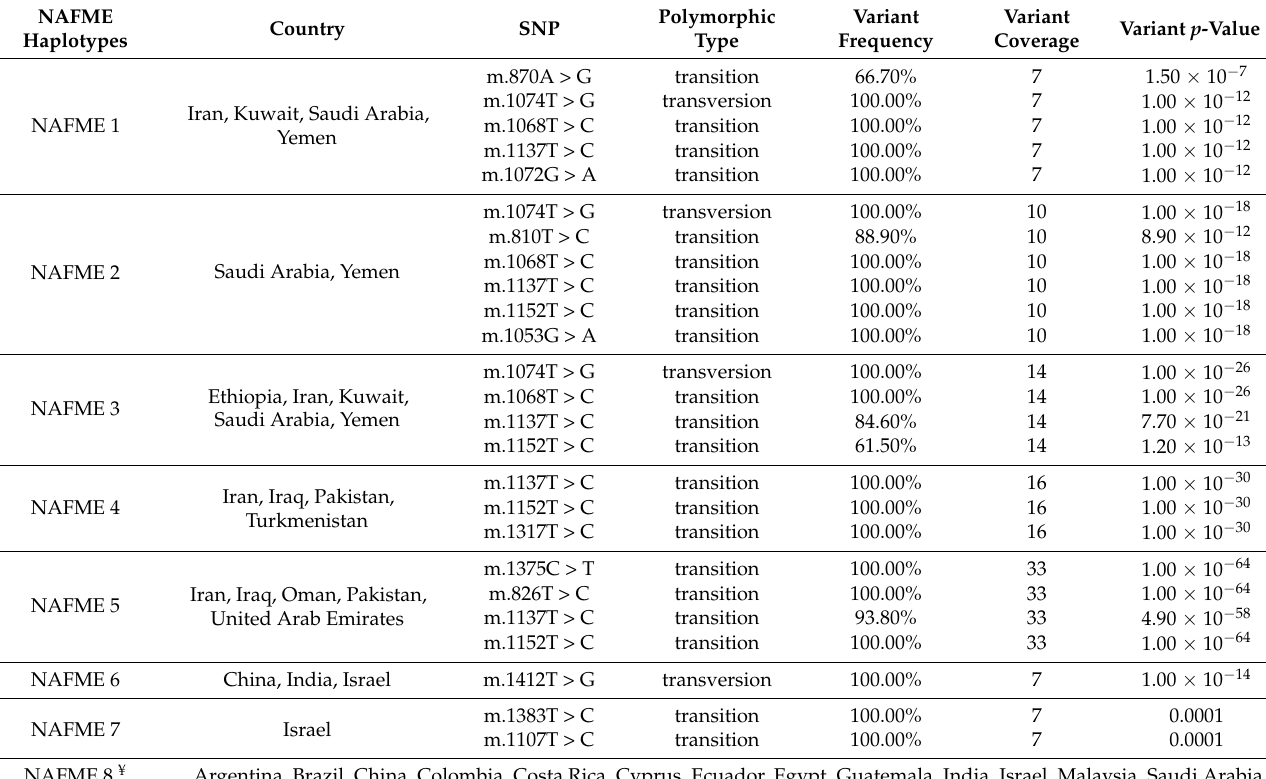
Table 1. Summary and description of signature single nucleotide polymorphisms (SNPs) used for differentiation of haplotypes of the B mitotype of Bemisia tabaci . The North Africa-Middle East (NAFME) region is the extant origin of haplotypes used in this study, based on collection sites.